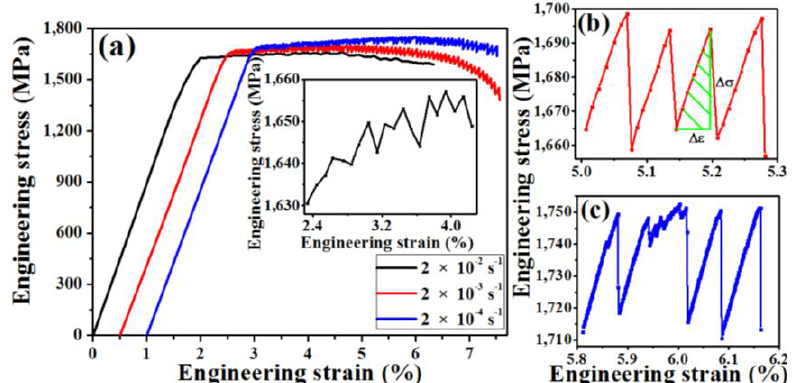
Figure 1. ( a ) Engineering stress-strain curves of the Pd 75 Si 15 Ag 3 Cu 7 bulk metallic glass (BMG) compressed at three strain rates. Inset shows the local engineering stress-strain curve at the strain rate of 2 × 10 −2 ·s −1 . ( b , c ) Serration events are selected randomly at the strain rates of 2 × 10 −3 and 2 × 10 −4 ·s −1 , respectively.